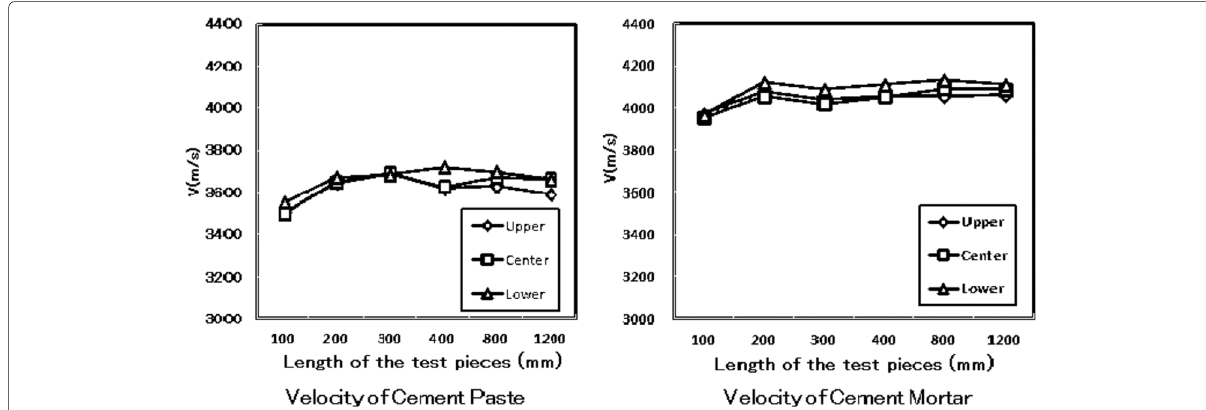
Fig. 2 Normal test pieces (age of a week)